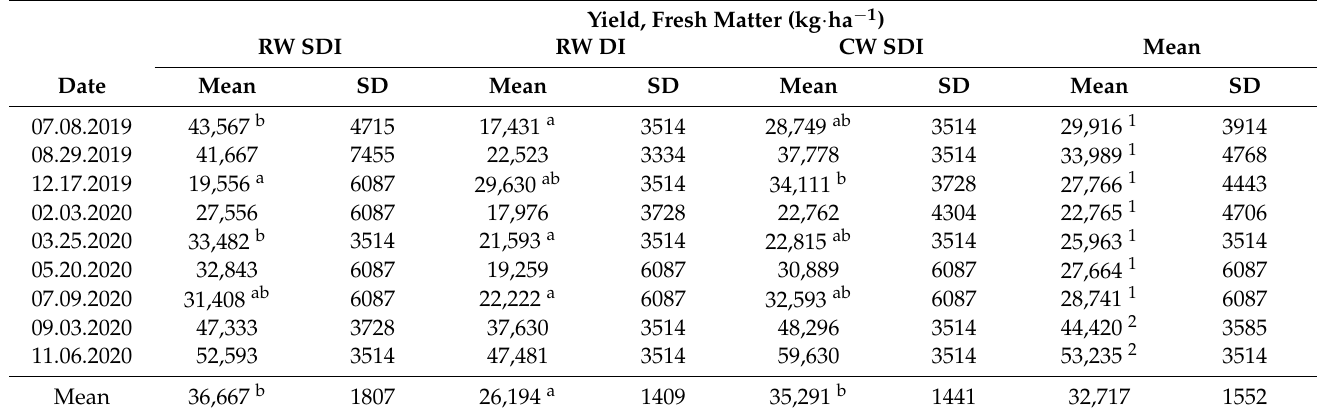
Table 6. Mean and SD of fresh yield (kg FM · ha − 1 ) obtained per harvest and treatment. Yield, Fresh Matter (kg · ha − 1